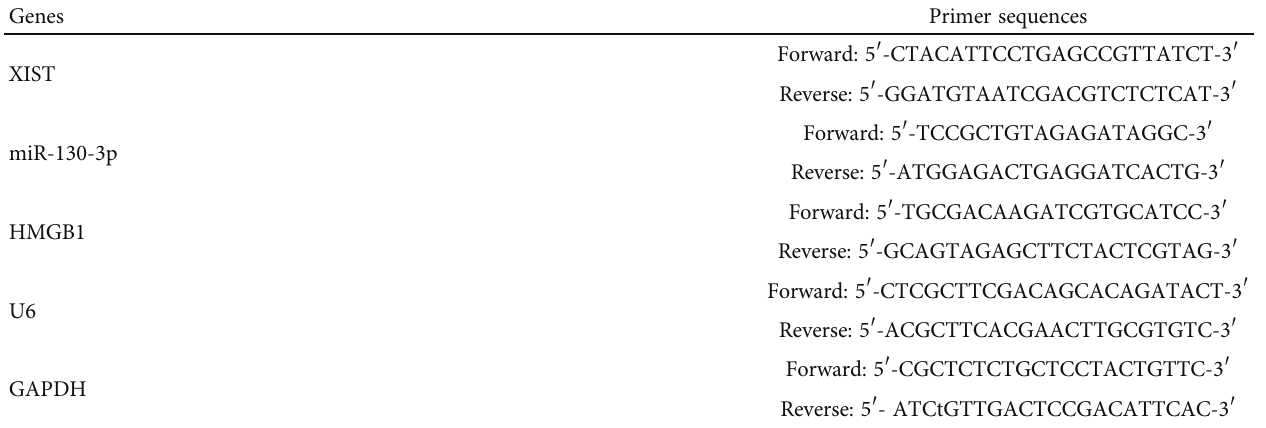
Table 2: Primers used for qRT-PCR.